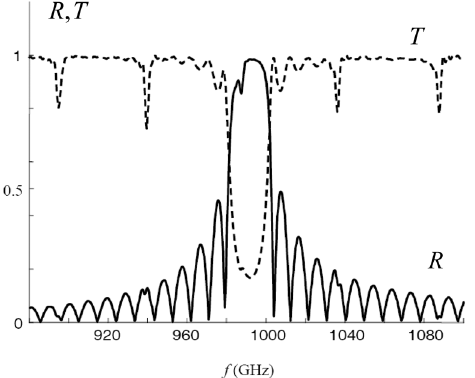
FIG. 3. Reflection (solid line) and transmission (dashed line) coefficients vs frequency in 3D simulations.